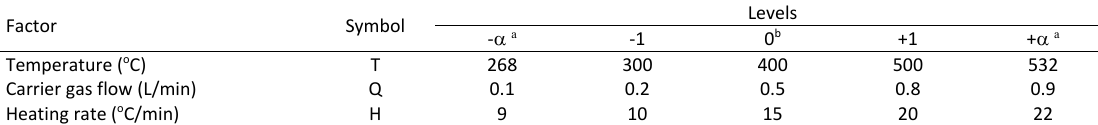
Table 2: Variables and their levels used in the central composite design